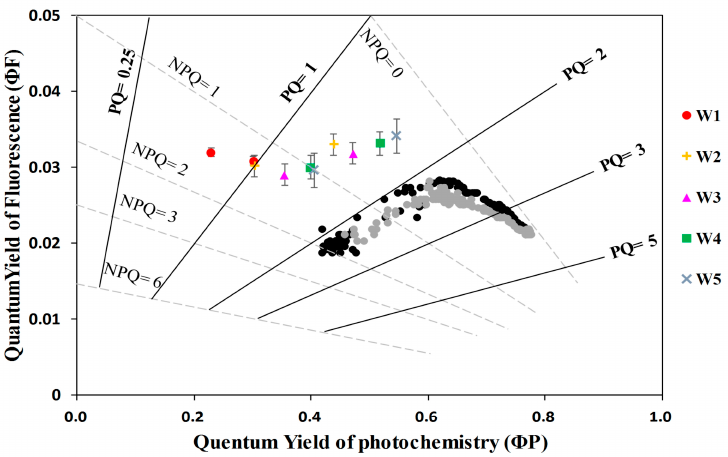
Figure 6. Color points show the relationship between Φ P and Φ F at different water stress levels. Data were obtained using the Licor-6400 (Licor Inc., Lincoln, NE, USA) instrument during the day in the early growing stage, and there are five soil moisture levels, ranging from 20% to 90% of the field capacity. For a comparison, Scots pine data in Porcar-Castell et al. (2014) are also presented (black points represent to data from midnight to noon, grey points represent the data from noon to midnight).